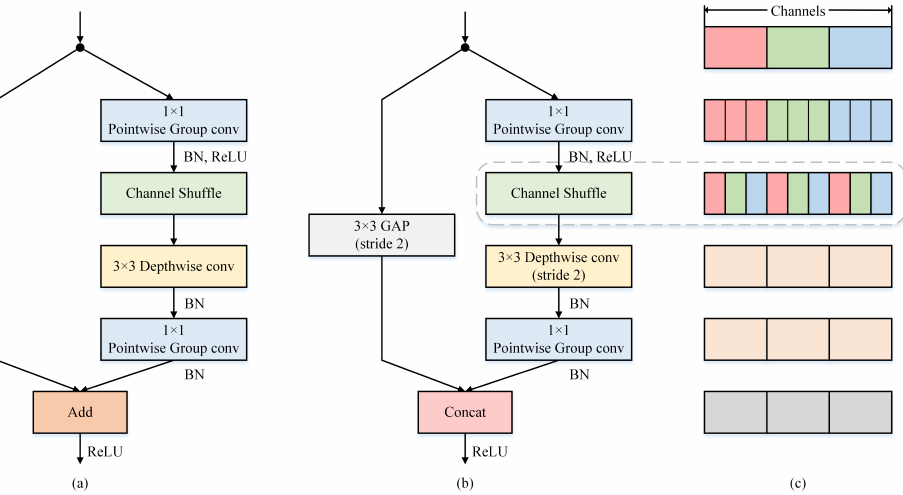
Figure 33. ( a ) ShuffleNetV1 unit with stride = 1. ( b ) ShuffleNetV1 unit with stride = 2 (down sampling, 2). ( c ) Channel shuffle